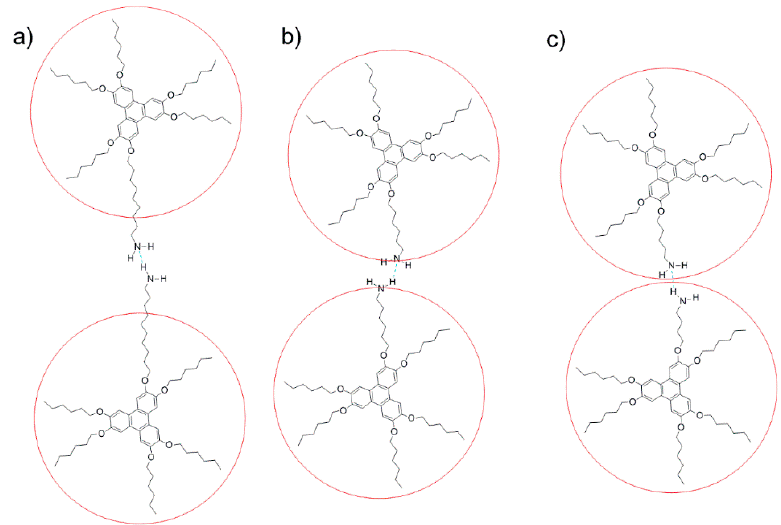
Figure 5. Schematic representation for the self-assembly of triphenylene amines through hydrogen bond (dashed blue line). ( a ) Amine 6 , hydrogen bond was observed in FT-IR studies; ( b ) amine 5 , the amine group is on the edge of the alkyl corona (in red) and ( c ) amine 4 , in this case hydrogen bond dimerization is disfavored due to steric hindrance.